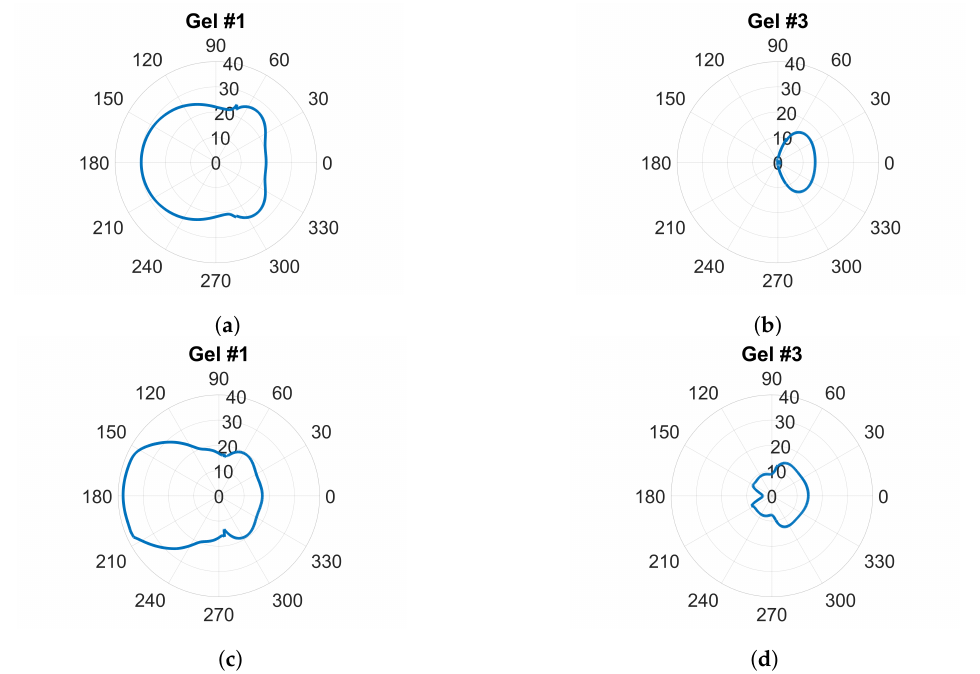
Figure 9. E-field sampled at a circle with radius λ around a single transmitting antenna: ( a , b ) at 0.7 GHz; ( c , d ) at 1.65 GHz.